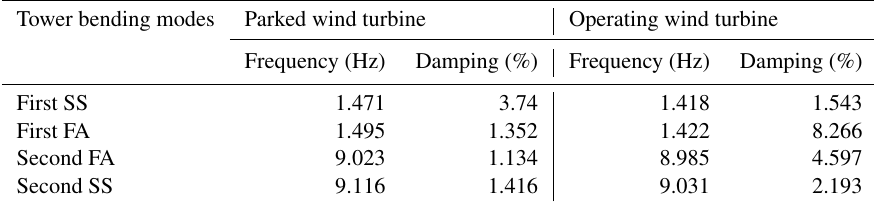
Table 2. Natural frequencies and damping ratios of a wind turbine tower during OP and PA conditions.